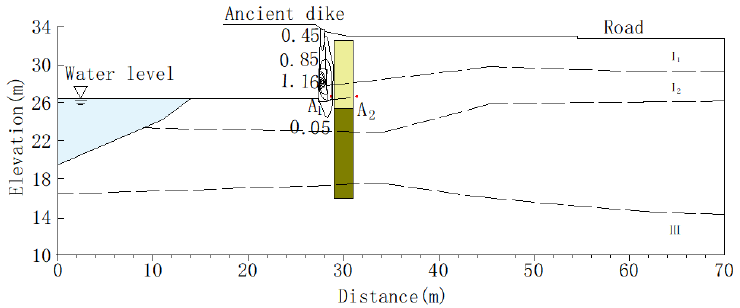
Figure 17. Distribution of hydraulic gradient of ancient riverbank with antiseepage wall.